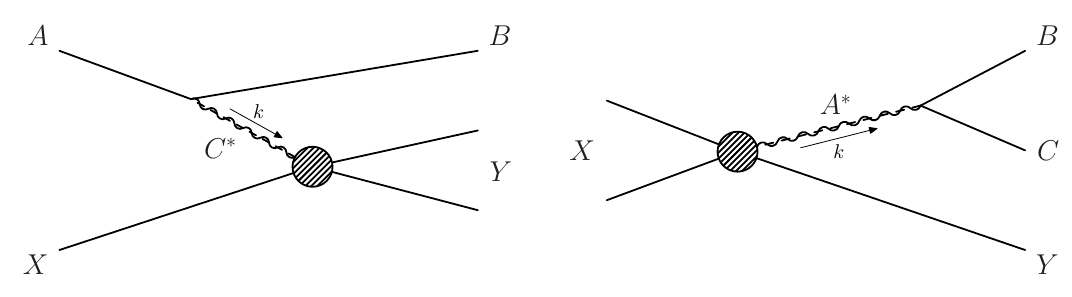
Figure 8: Pictorial representation of the leading contributions in the factorizable AX → BY and X → BCY processes. The dashed blob represents the hard